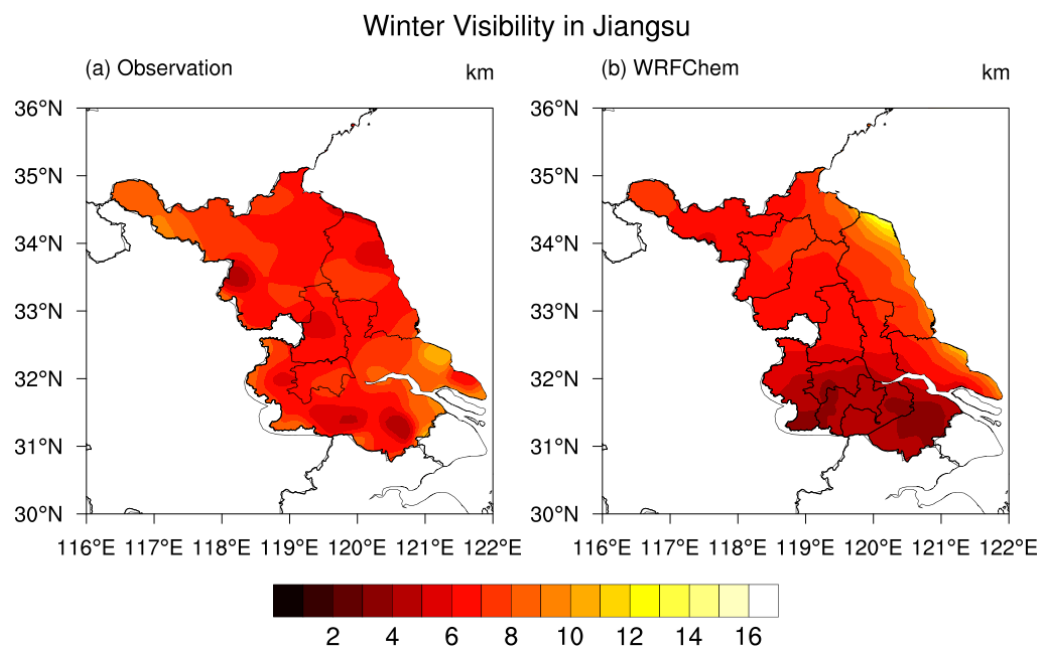
Figure 4. Mean visibility in winters of 2013–2017 in Jiangsu Province based on ( a ) observation and ( b ) WRF-Chem model output products. Atmosphere 2018 , 9 , x FOR PEER REVIEW Table 1. Correlation coefficient (R), root mean square error (RMSE), mean fractional error (MFE), and mean fractional bias (MFB) of the multi-winter (2013–2017) mean 3-hourly T 2 , RH 2 , WS 10 , and VIS simulated by WRF-Chem model compared to the observation in Jiangsu Province.